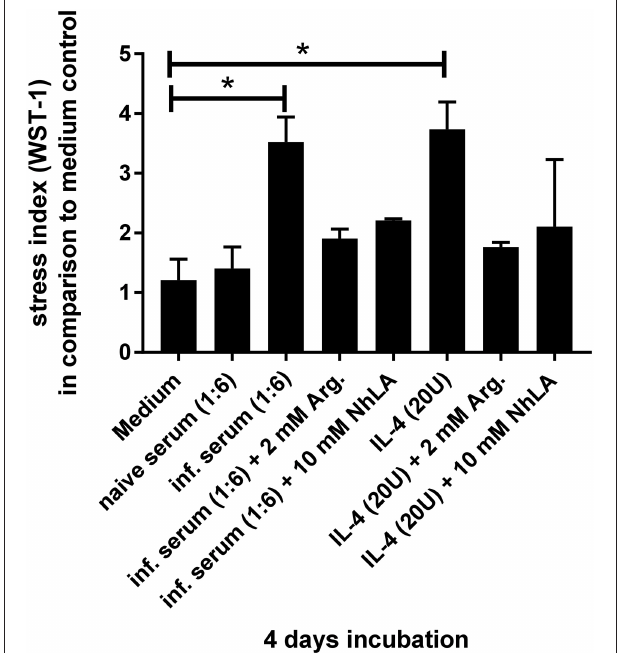
FIGURE 8 | Examination of cellular stress induced by different stimuli. The designated stimuli were incubated for 4 days with stromal cells of naïve C57BL/6 wild-type mice and subsequent measurement of metabolized tetrazolium salt to formazan. The data were analyzed for significances in comparison to medium control with six independent samples, using the non-parametric Mann–Whitney U test. * p >